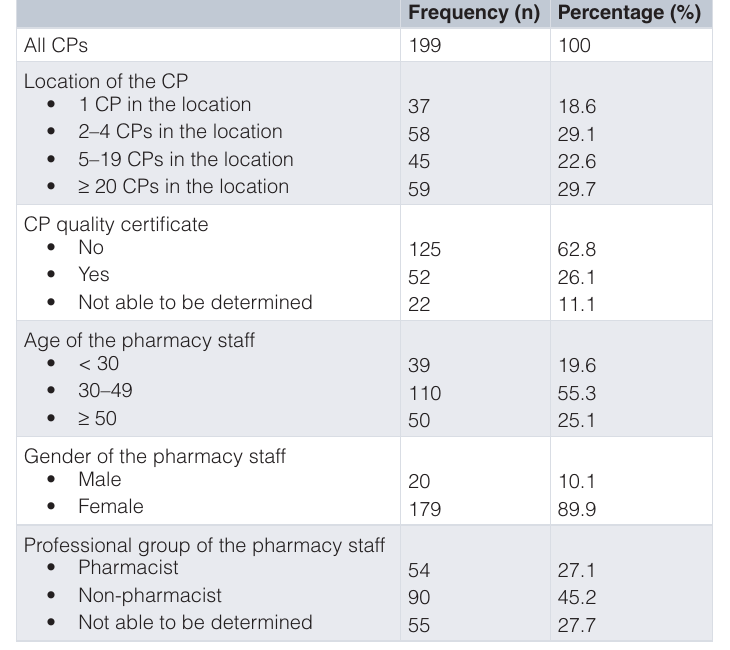
Table 3. Socio-demographic data for the CPs and the advising pharmacy staff.